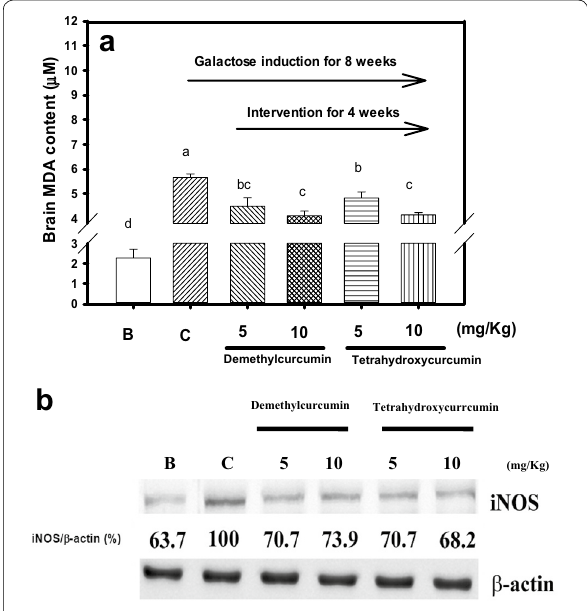
Fig. 4 Effects of demethylcurcumin or tetrahydroxycurcumin interventions (5 and 10 mg/kg) on brain extracts of a MDA contents and b iNOS protein expressions in d ‑galactose‑induced mice. The iNOS antibody was used in a 2000‑fold dilution, and β‑actin was used in a 10,000‑fold dilution. The images of the immune stain on the PVDF membranes were quantified and expressed as folds of iNOS/ actin by the relative density (%) to the control (100%). Values were presented as mean SD and were analyzed using one‑way ANOVA, ± followed by a post hoc Tukey’s test for multiple comparisons. The P < 0.05 was considered statistically significant and marked on the column with different letters among